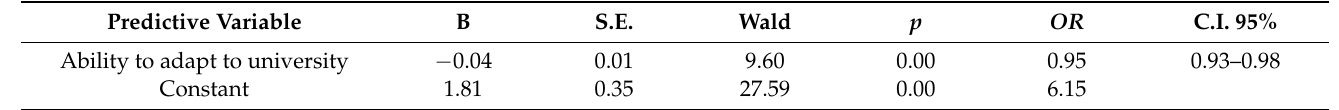
Table 3. Results derived from binary logistic regression for the probability of being a cyberbully. Predictive Variable Ability to adapt to